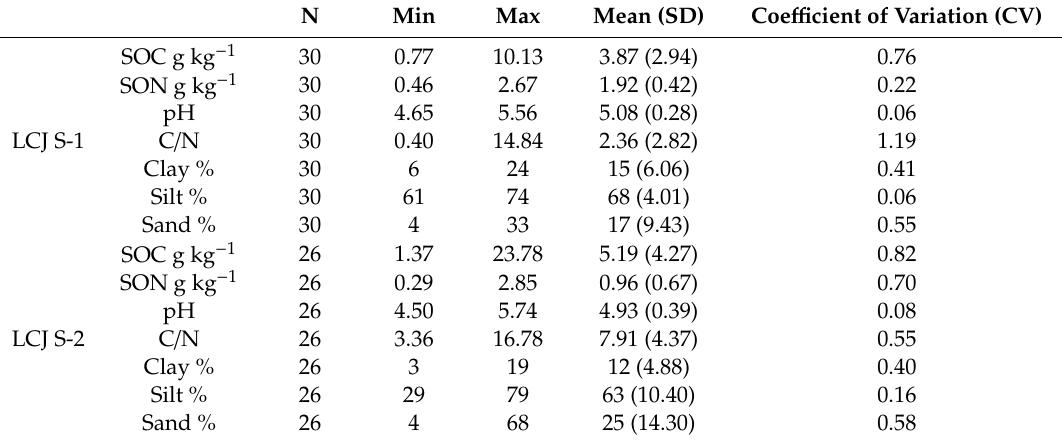
Table 2. Data description for SOC, SON and other soil properties in soil profiles LCJ S-1 and LCJ S-2. N Min Max Mean